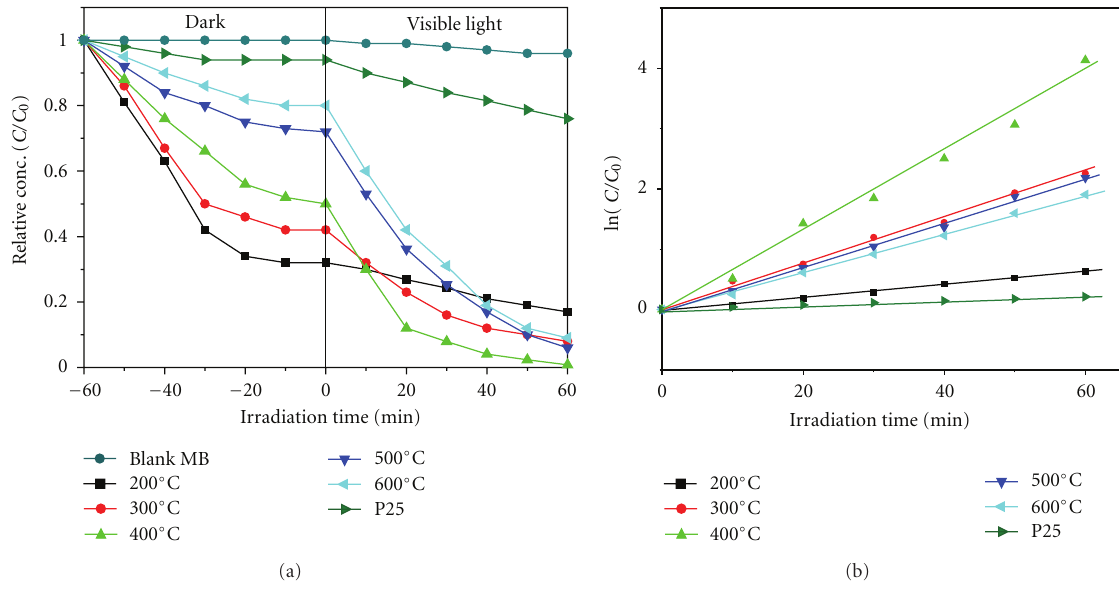
Figure 6: (a) The blank MB solution, photodegradation of methylene blue solutions by using IT-T and P25 under visible light in a neutral suspension. (b) The variation of normalized ln( C 0 /C ) of MB concentration as a function of visible light irradiation time.